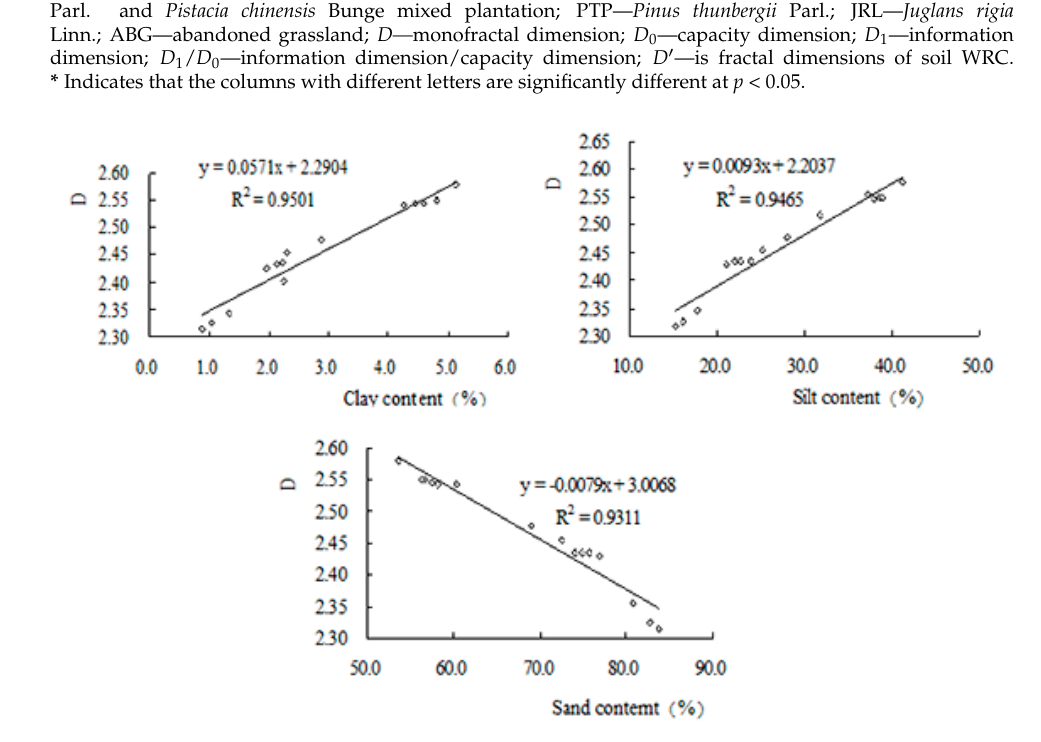
Figure 3. Multifractal spectra of soil PSD under the different vegetation types in the study area QRM— Quercus Acutissima Carr. and Robina Pseudoacacia Linn. mixed plantation; PPM— Pinus thunbergii Parl. and Pistacia chinensis Bunge mixed plantation; PTP— Pinus thunbergii Parl.; JRL— Juglans rigia Linn.; ABG—Abandoned grassland.